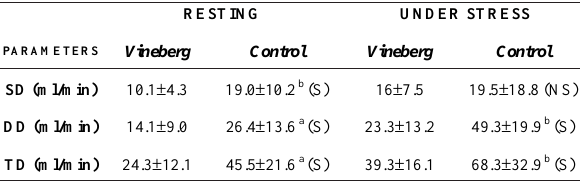
Table 2. Non-paired analysis of the flow in the left internal thoracic artery obtained by echodoppler at rest and under stress between groups A (control group) and B (Vineberg group).